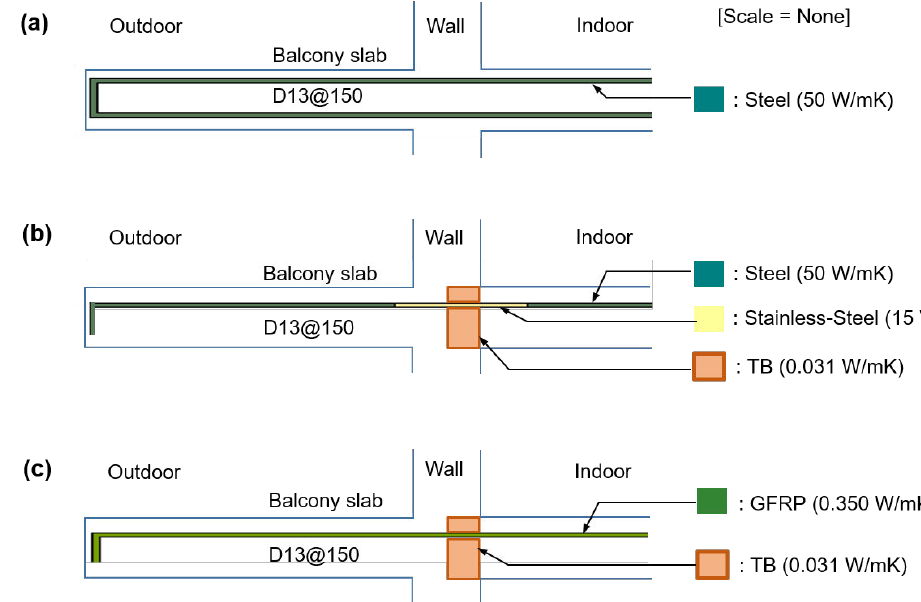
Figure 1. Diagram of ( a ) Reference (steel), ( b ) TB element and ( c ) TB-GFRP